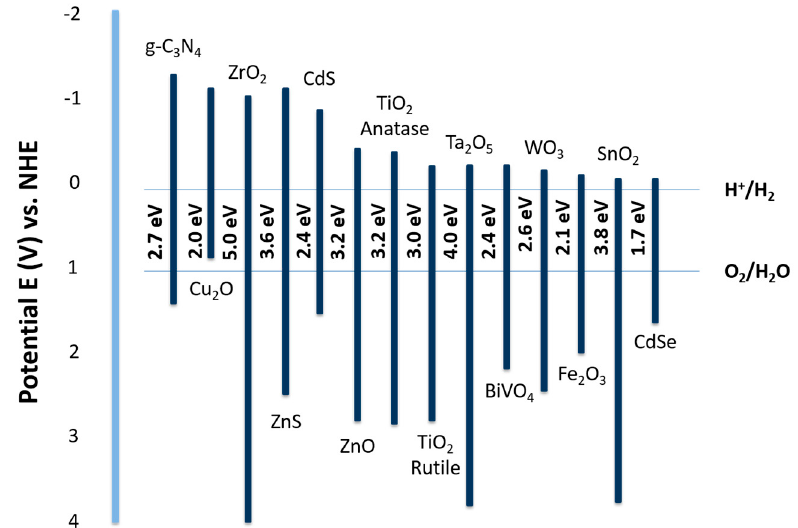
Figure 3. Band structure illustration of various semiconductors with respect of the redox potentials of water splitting. Figure adapted from reference [142] of Ong et al. work.